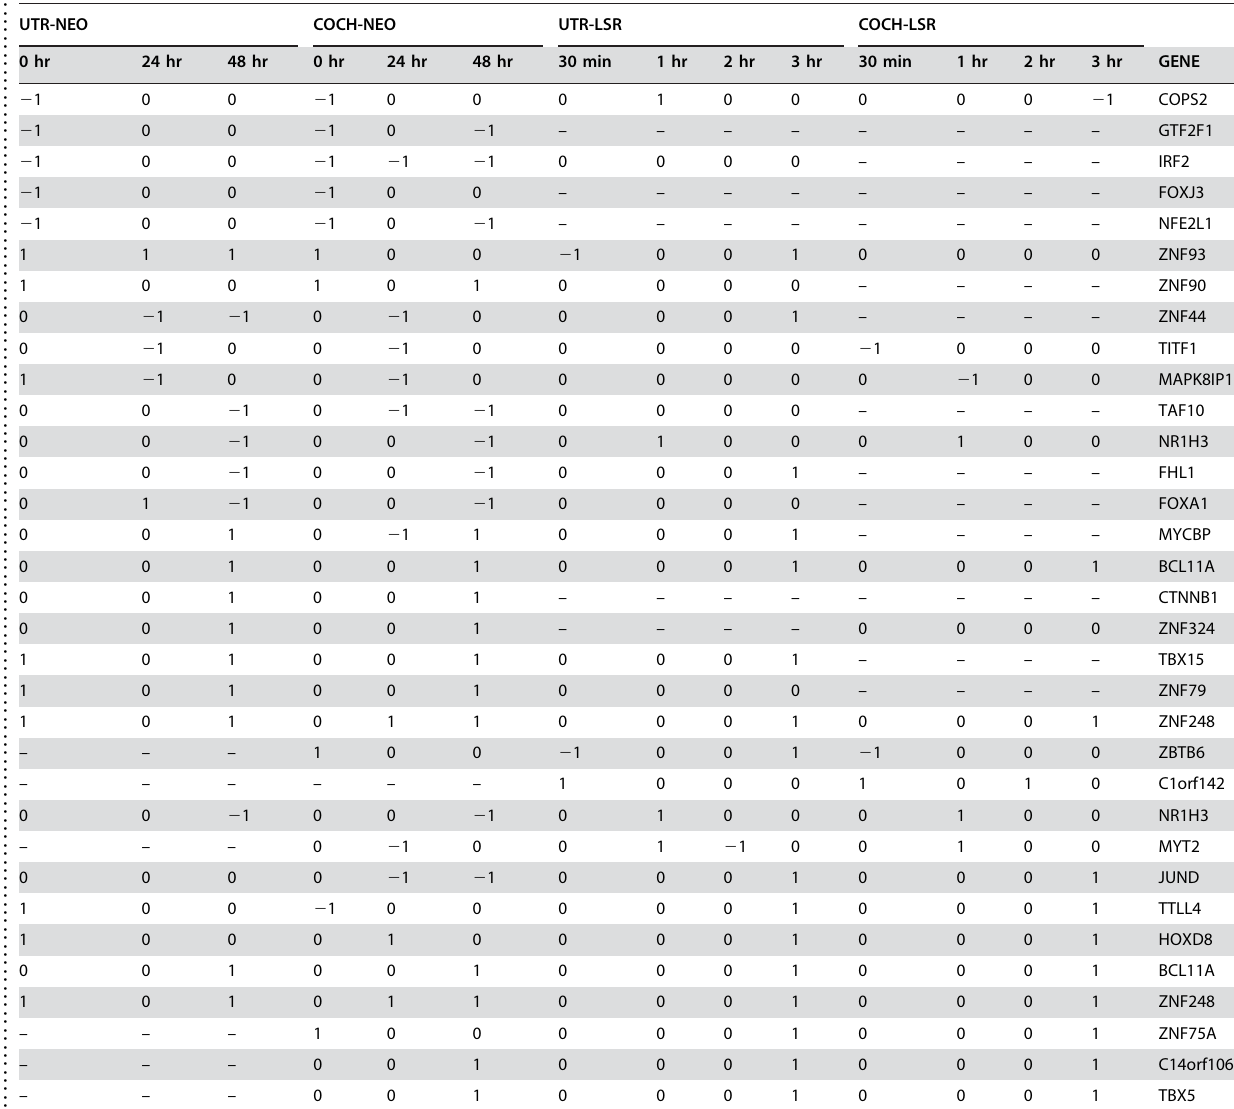
Table 2. Genes that exhibit identical patterns of expression in at least one identical time-point. .. ... .... ... ... .... ... ... .... ... ... .... ... ... .... ... ... .... ... ... .... ... ... .... ... ... .... ... ... .... ... ... .... ... ... .... ... ... .... ... ... .... ... ... . UTR-NEO COCH-NEO